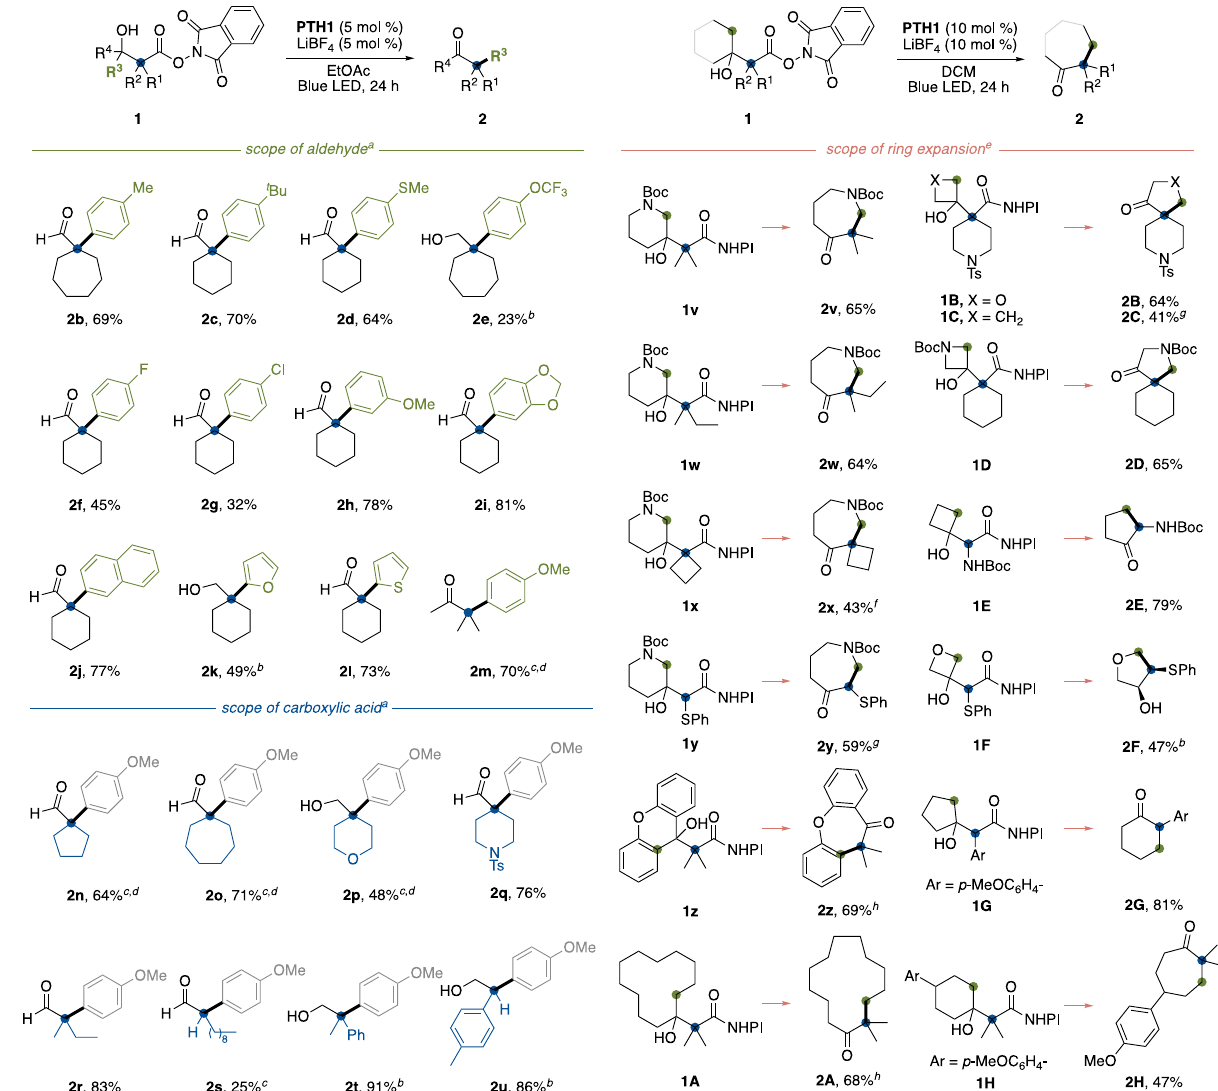
Fig. 2 Substrate scope of decarboxylative semipinacol rearrangement. a Reaction was carried out with 1 (0.2 mmol), PTH1 (0.01 mmol), LiBF 4 (0.01 mmol), EtOAc (0.6 mL), 24 h under blue LED irradiation. b The product was isolated as the alcohol through reduction by NaBH 4 (0.4 mmol) in MeOH (5.0 mL). c PTH1 (0.02 mmol) and LIBF4 (0.02 mmol) were used. d MeCN (0.6 mL) was used instead of EtOAc. e Reaction was carried out